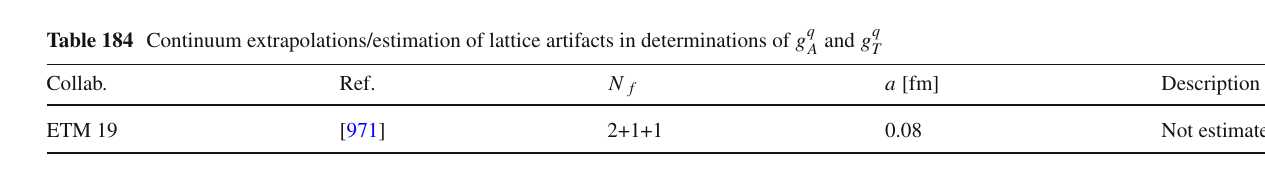
Table 185 Chiral extrapolation/minimum pion mass in determinations of g q Collab.